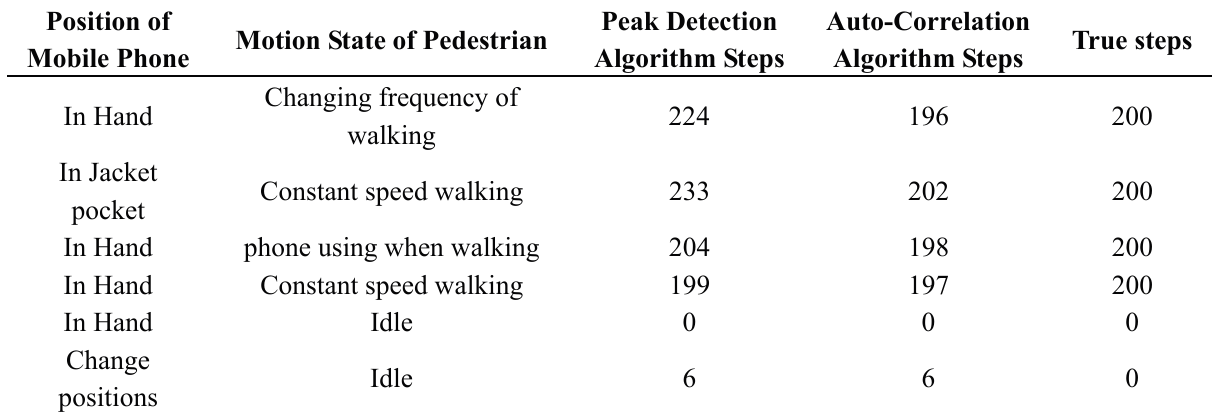
Table 2 lists the test results for the auto-correlation algorithm and the peak detection algorithm. Table 2. Performance of the auto-correlation